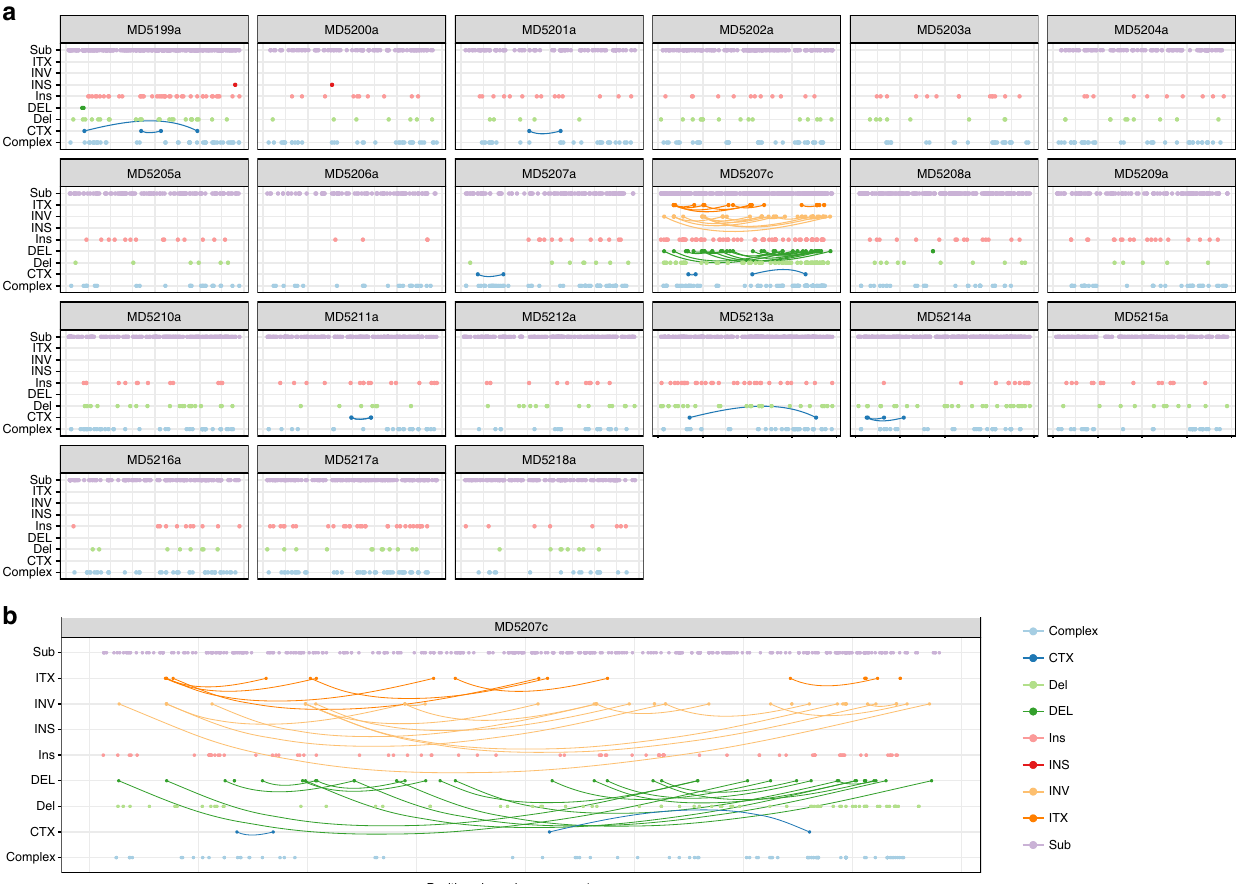
Fig. 6 Chromothripsis in radiation-induced tumours. a Mapping of different somatic mutation types across chromosome 1 in all of the whole genome sequenced mammary tumours. Sub: Substitutions, ITX: Intrachromosomal translocation, INV: Inversion rearrangements, INS: Insertion rearrangements, DEL: Deletion rearrangements, CTX: Interchromosomal translocation, Ins: Small Insertions, Del: Small deletions, Complex: Complex INDELS. b Sample MD5207c has a strikingly large number of mutations of different types spread widely across the length of the chromosome, indicative of whole chromosome